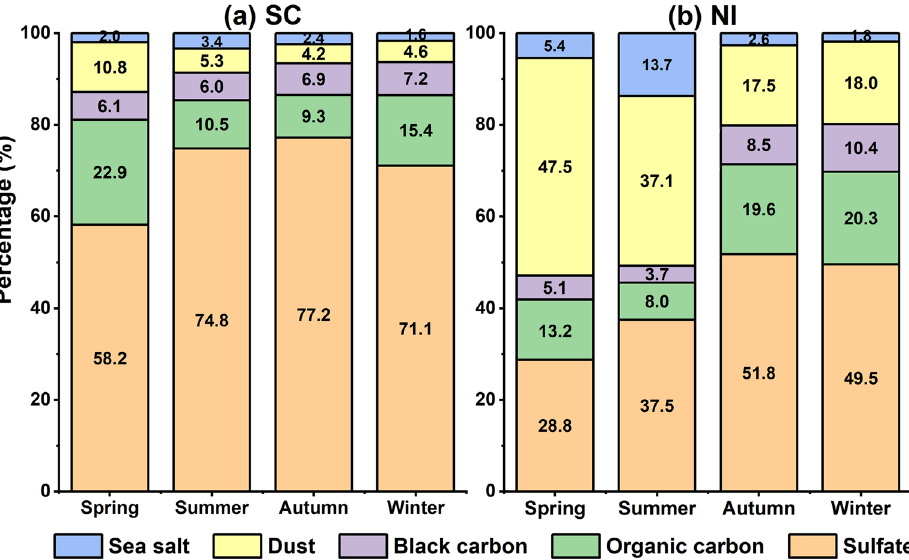
Figure 8. The percentages of the AOD of five aerosol types to the total AOD in ( a ) the SC and ( b ) the NI in the four seasons (Unit: